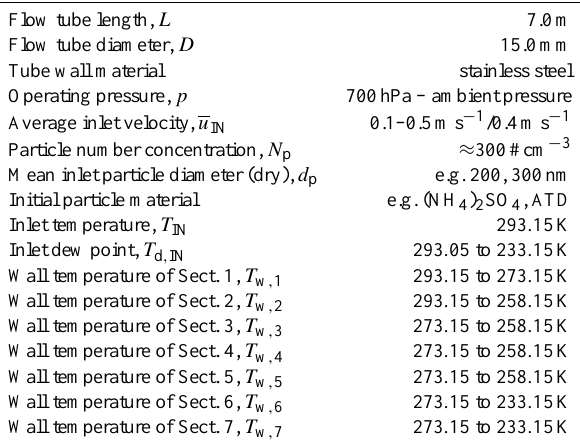
Table 1. LACIS operating